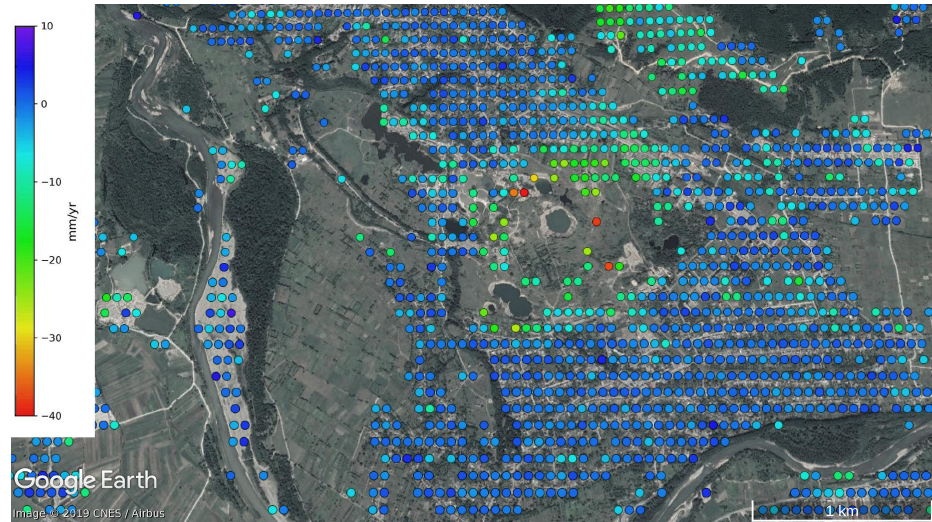
Figure 11. Vertical deformation rate determined from Sentinel-1 data from track 29 and track 80. Contains modified Copernicus Sentinel data (2014–2019), background © Google Earth.